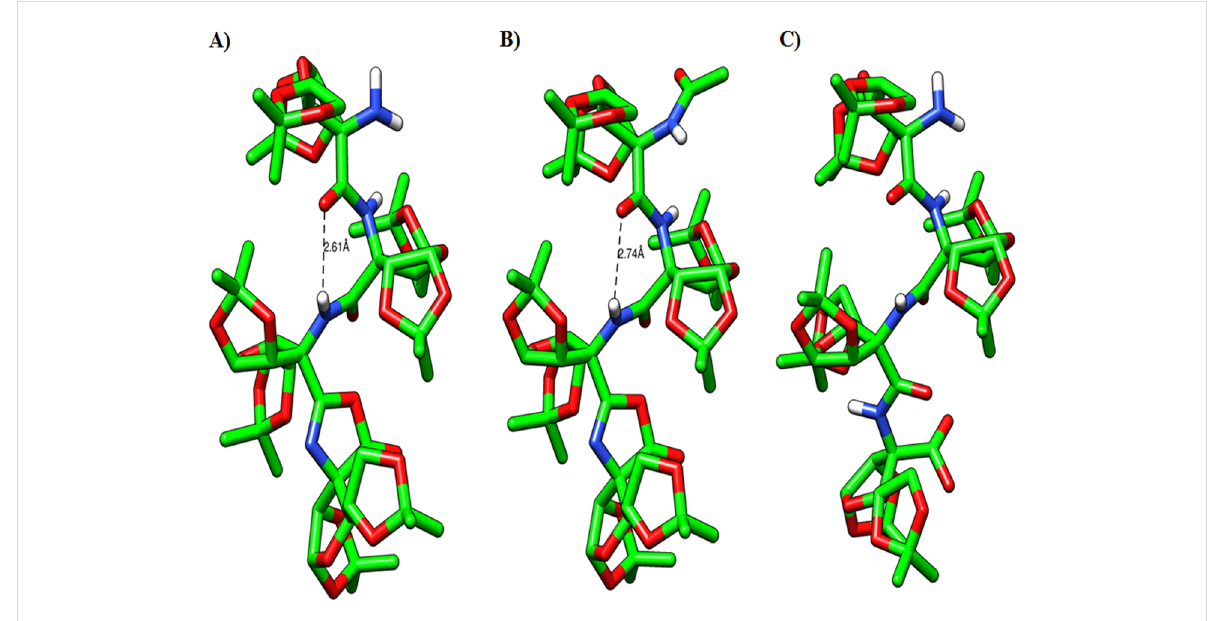
Figure 5: Optimized helical conformations of (A) 2a , (B) 2b and (C) 9 .